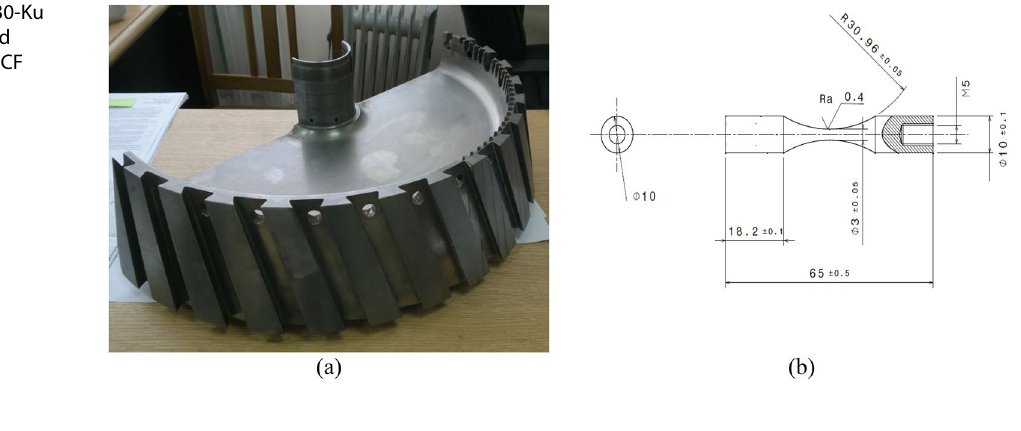
Fig. 3 Titanium disk of D30-Ku engine compressor ( a ) and specimens for uniaxial VHCF tests ( b )